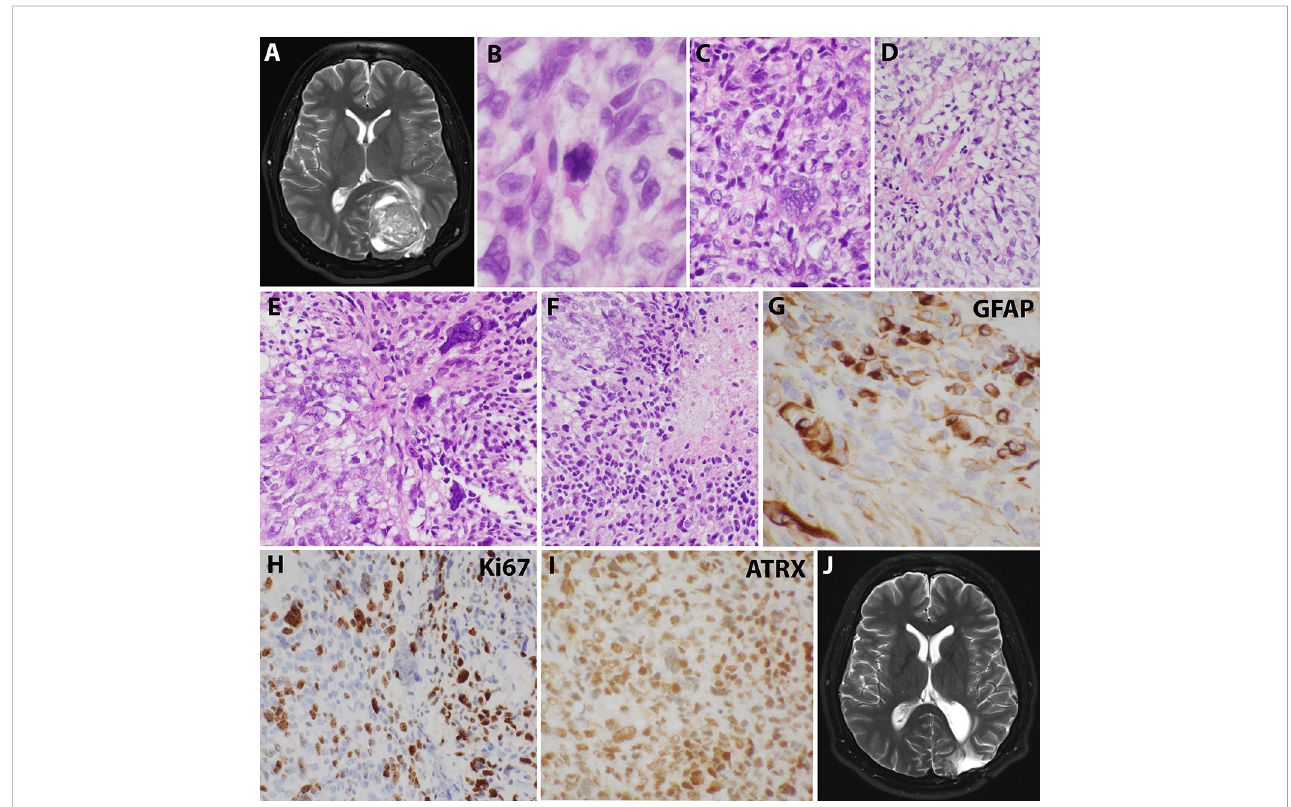
FIGURE 3 Imaging and microscopic studies of the newly recurrent tumor. (A) , Imaging revealed a 6 cm irregular, contrast-enhancing mass with solid and cystic components associated with the prior tumor site causing signi fi cant mass effect. (B – F) , H&E staining showed heterogeneous and poorly differentiated tumor cells with atypical mitotic fi gures (B) , numerous bizarre multinucleated giant cells (C) , clear cells change with eccentrical nuclei (D) , fusiform and pleomorphic monstrous nuclei (E) , and foci of palisading necrosis with tumor cells lining the ischemic edges (F) . (G) , Pleomorphic tumor cells were positive for GFAP staining. (H) , Ki67 stain showed high mitotic index. (I) , ATRX stain was retained. (J) , Postoperative imaging demonstrated stable enhancing foci in the surgical